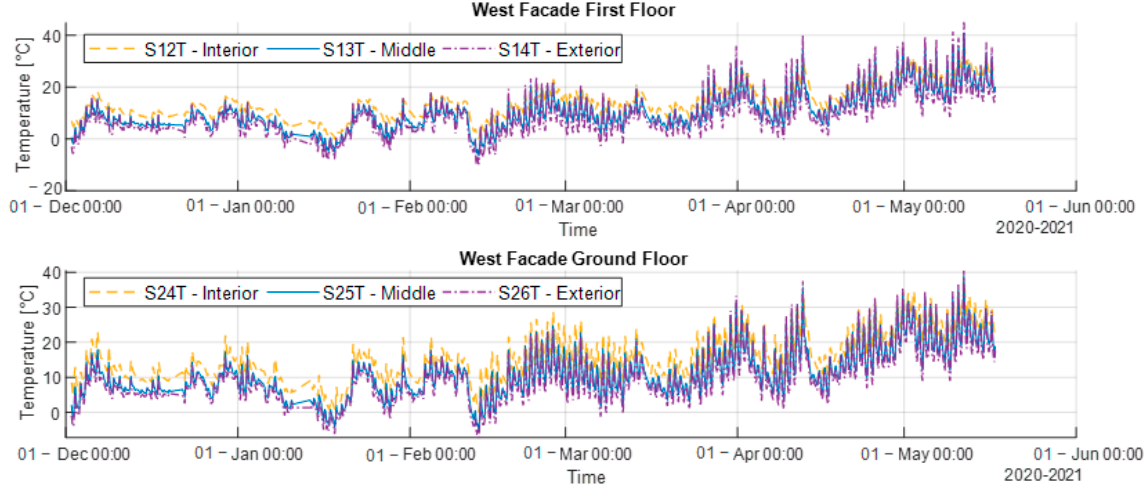
Figure 14. Temperature data provided by the sensors for the eastern façade first floor (above) and ground floor (below).